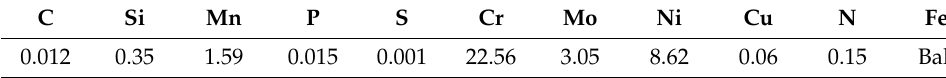
Table 2. Nominal chemical compositions (wt.%) of the ER2209 welding wire.